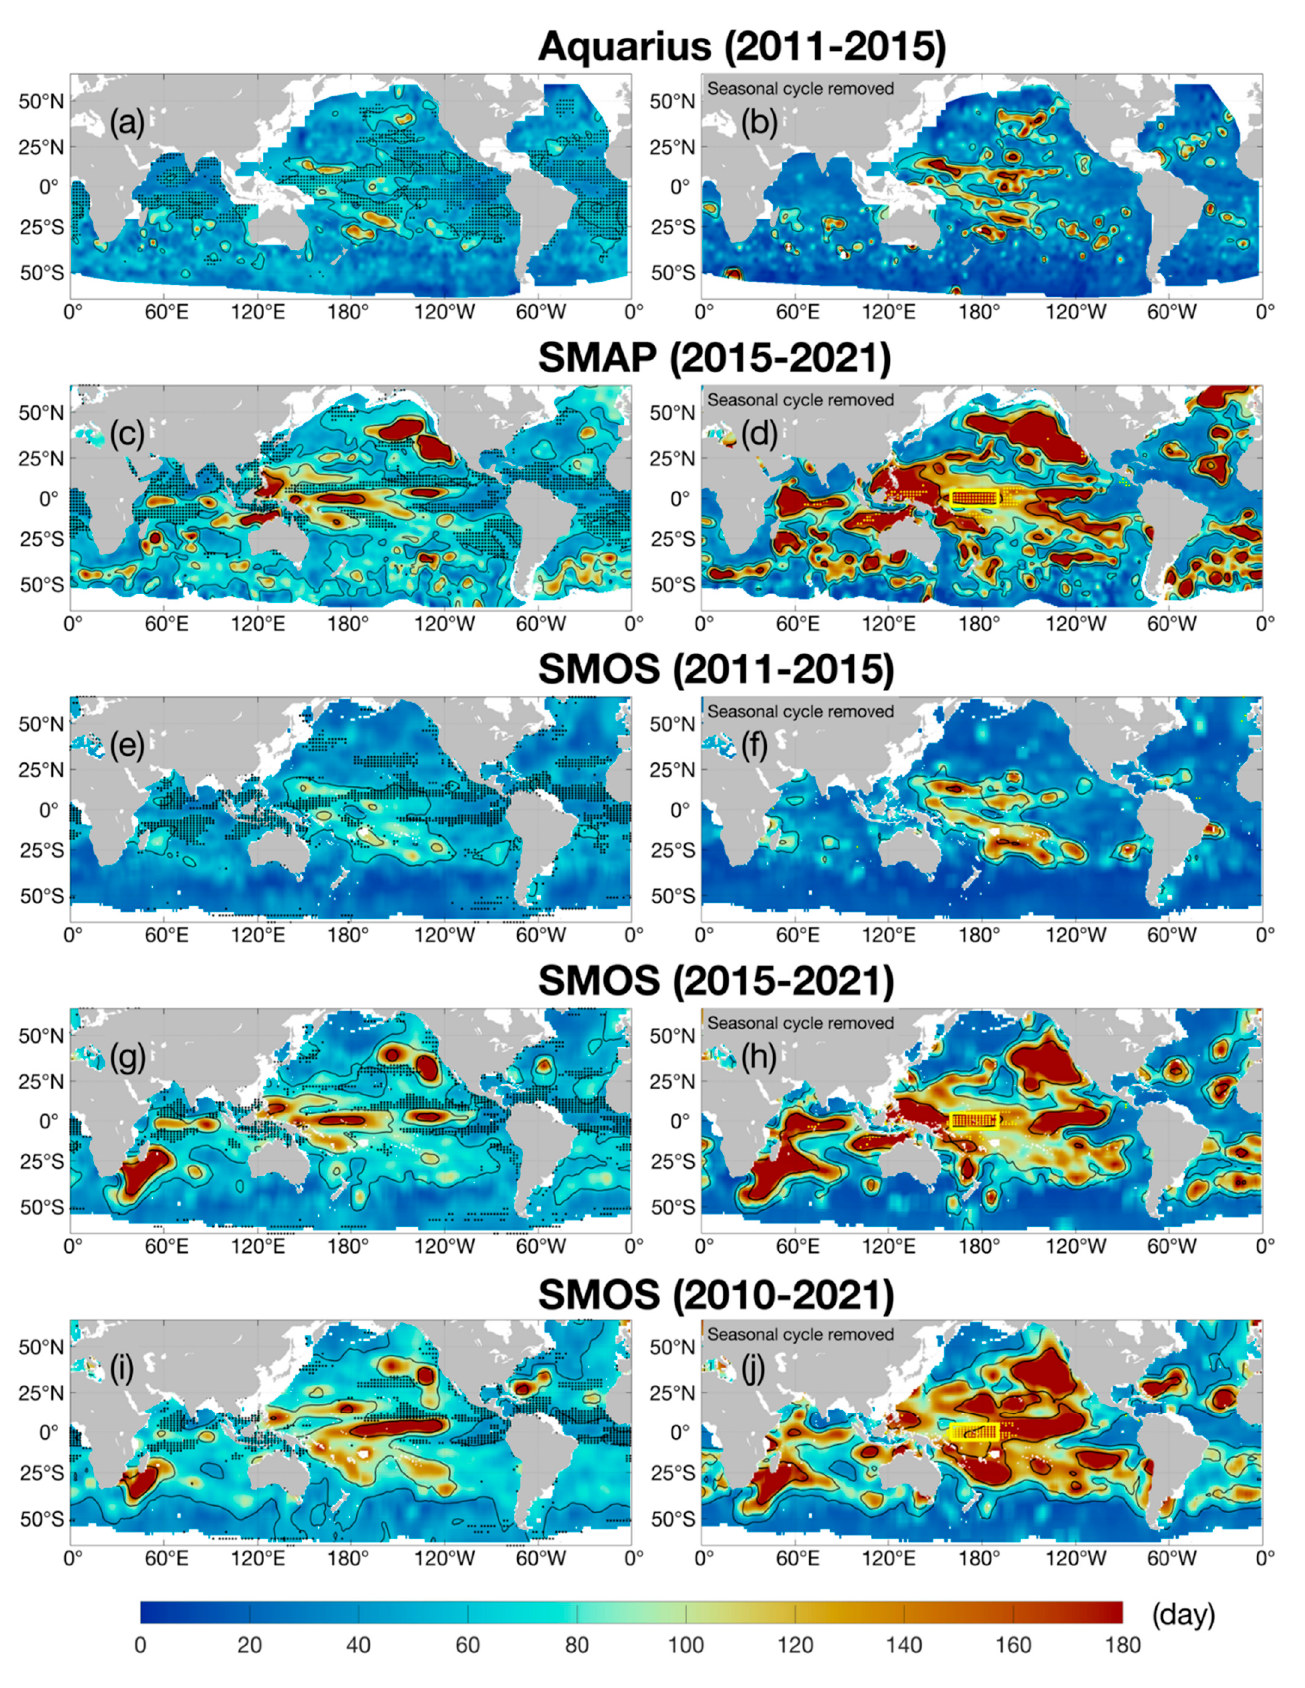
Figure 2. Temporal scales (days) of SSS variability derived from ( a , b ) Aquarius, ( c , d ) SMAP, and ( e – j ) SMOS satellite data. The SMOS dataset is split into three segments: ( e , f ) covering the